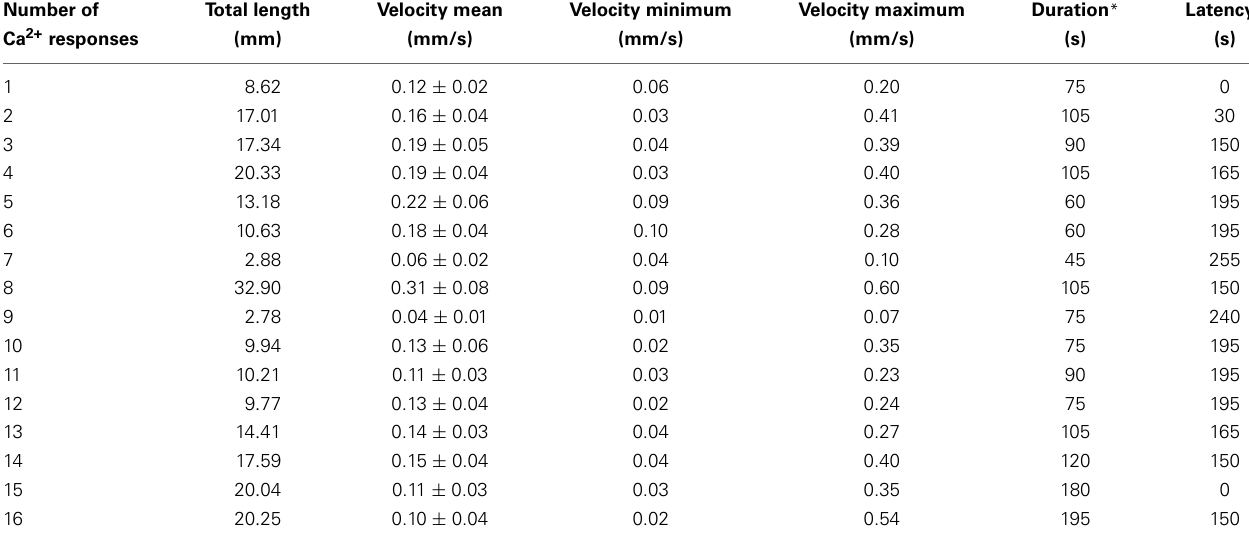
FIGURE 9 | Analysis of the propagation of calcium elevation in detached leaves induced by high salt exposure. (A) Ca 2 + responses on each vein were analyzed in ImageJ. Velocities (mm/s) of Ca 2 + signals were determined along paths represented by dashed arrows (details of Ca 2 + signal velocity, Table 2 | Ca 2 + wave properties in detached leaves upon high salt